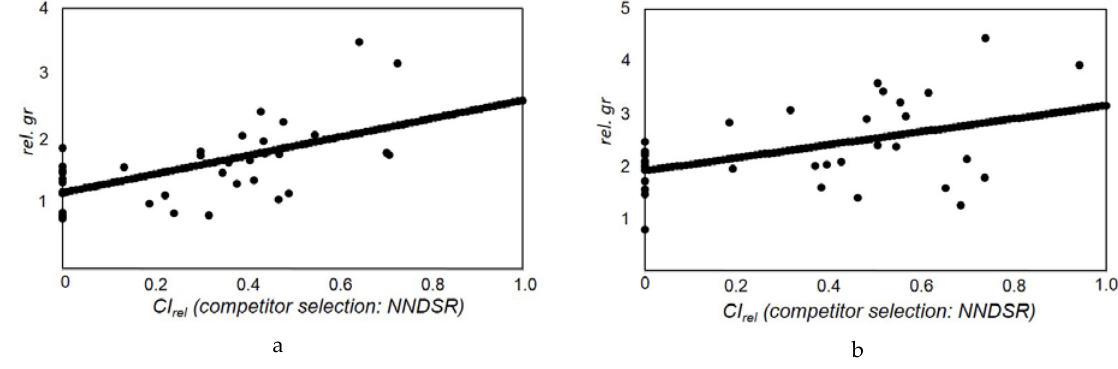
Figure 8. ( a ) Graph of the relationship between the relative competition relief (CI rel ) and relative change in basal area growth (rel.gr) of larch. ( b ) Graph of the relationship between the relative competition relief (CI rel ) and relative change in basal area growth (rel.gr) of birch.